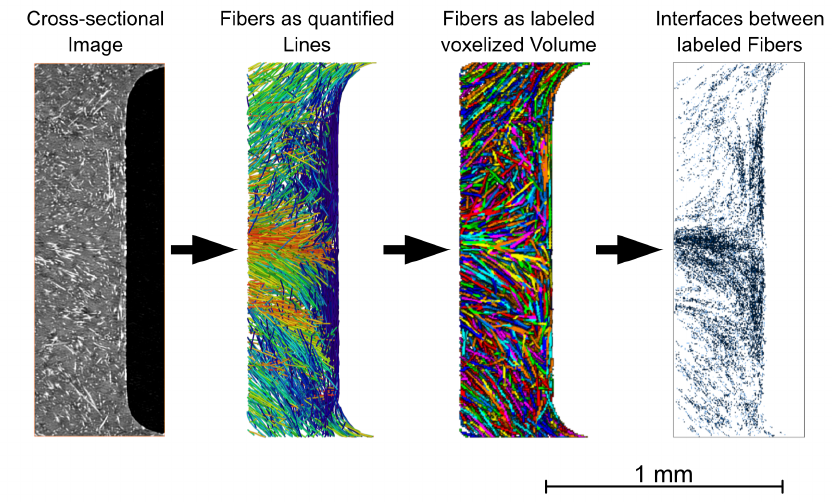
Figure 4. Evaluation method of the X-ray microtomography data.